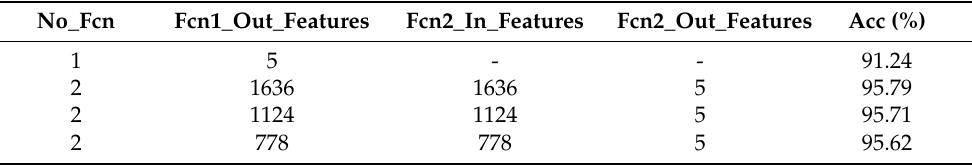
Table 2. Classification test accuracy of various feature